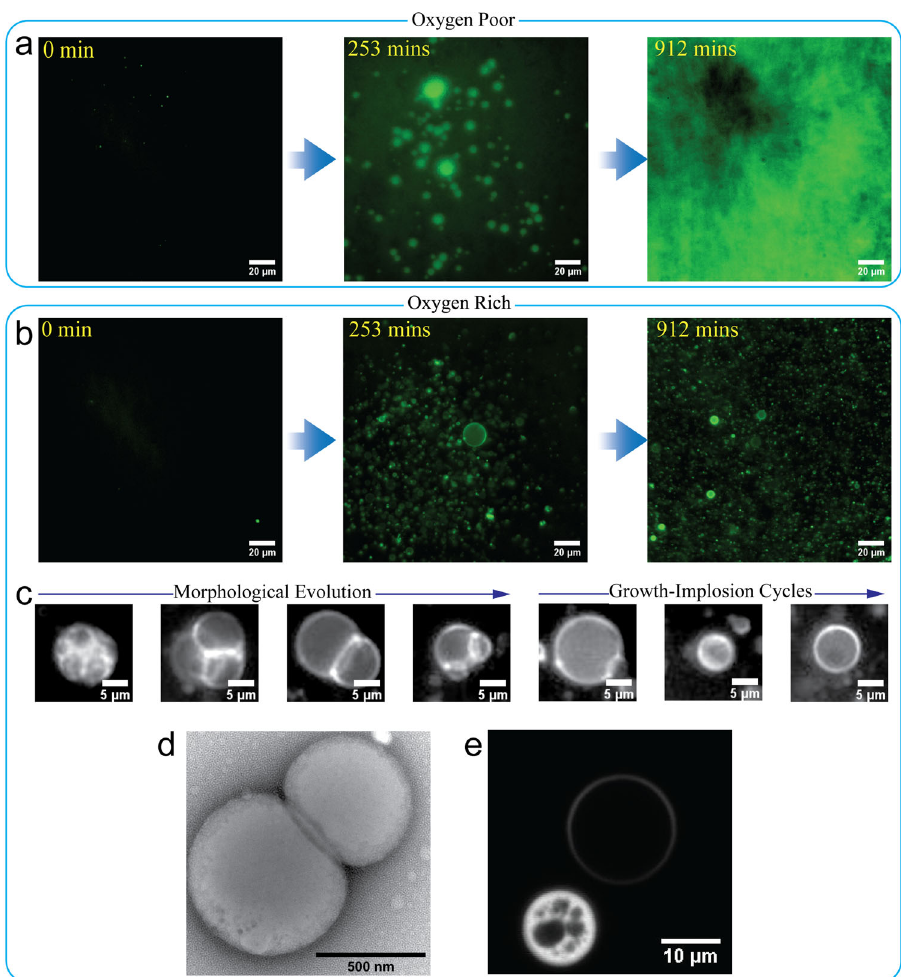
Fig. 2 Temporal evolution of two distinct morphological dynamics from PISA specimens. Morphologies of products obtained when exposed to blue light irradiation from the optical microscope. a Fluorescence images of the formation of the gelation in an oxygen-poor PISA specimen. b Fluorescence images of Phoenix dynamics in the oxygen-rich PISA specimen. c Snapshots of two consecutive morphological evolution stages of a large polymer object undergoing Phoenix dynamics in an oxygen-rich PISA specimen. d A TEM image of the giant object obtained from oxygen-rich specimen (scale bar = 500 nm). e Confocal microscope image of two polymer objects from oxygen-rich specimen after irradiation in a Zeiss Axiovert microscope (scale bar = 10